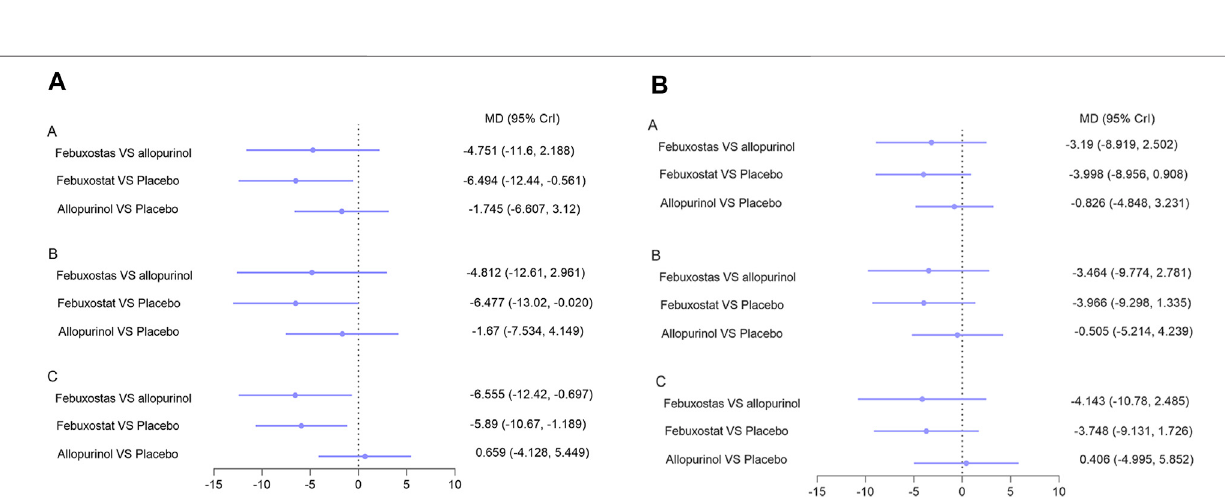
Frontiers in Pharmacology |